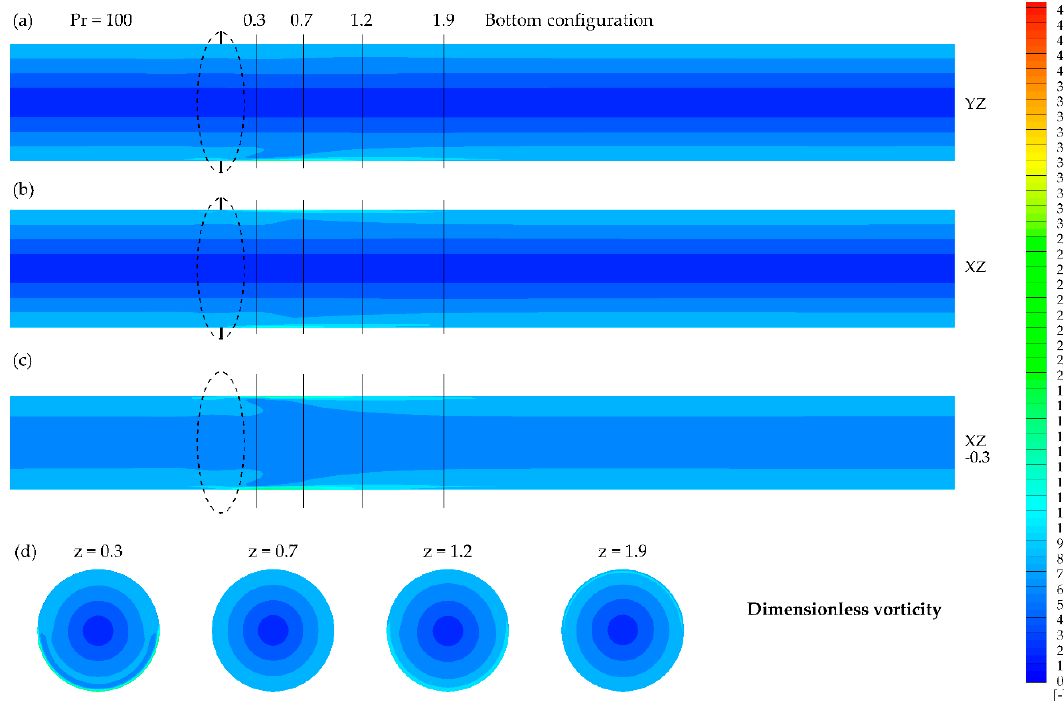
Figure 17. Dimensionless vorticity contours obtained for Pr = 100 and bottom configuration in the presence of the magnetic field at: ( a ) YZ plane, ( b ) XZ plane, ( c ) XZ plane ( y = − 0.3), ( d ) XY planes at given z .